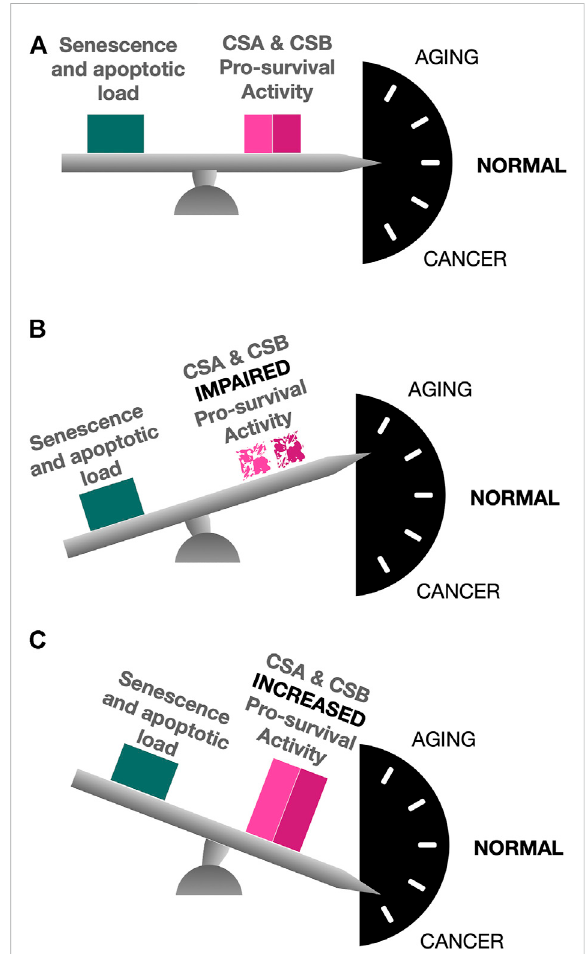
FIGURE 3 The balanced action of CS proteins. In normal conditions, CSA and CSB pro-survival activity counterbalances the signaling pathways that, otherwise, would lead to the induction of senescenceandthetriggeringofapoptosisinresponsetothe insults to which the cells are daily exposed (A) . Lack of CS proteins due to gene mutations causes an unbalance in which senescence and apoptotic load are not counteracted, thus leading to complex premature aging phenotypes (B) . A gain of CS proteins expression, instead, is responsible for an up-regulation of pro-survival pathways, thus favoring conditions for cancer development and progression (C)